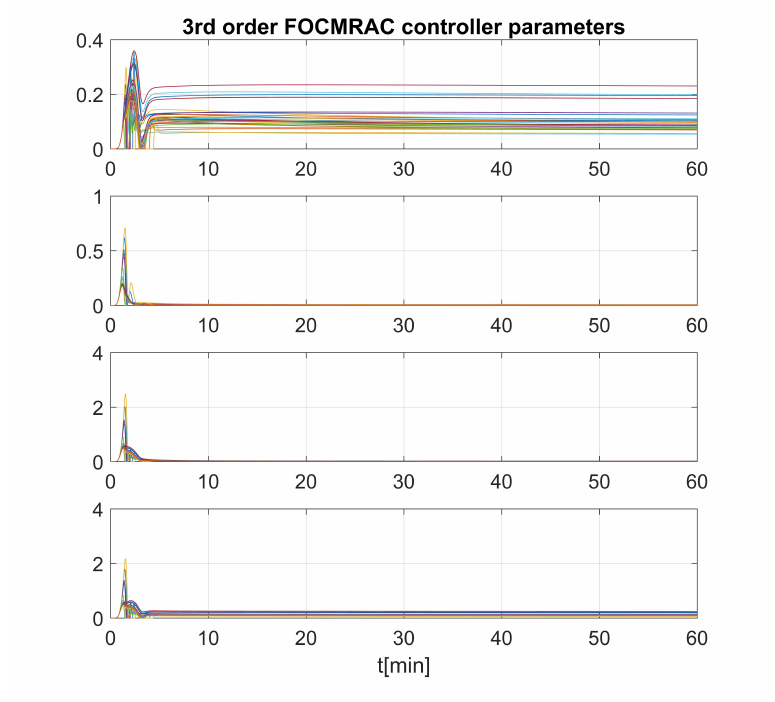
Figure 15. Controller parameters of the FOCMRAC scheme using the 3rd-order